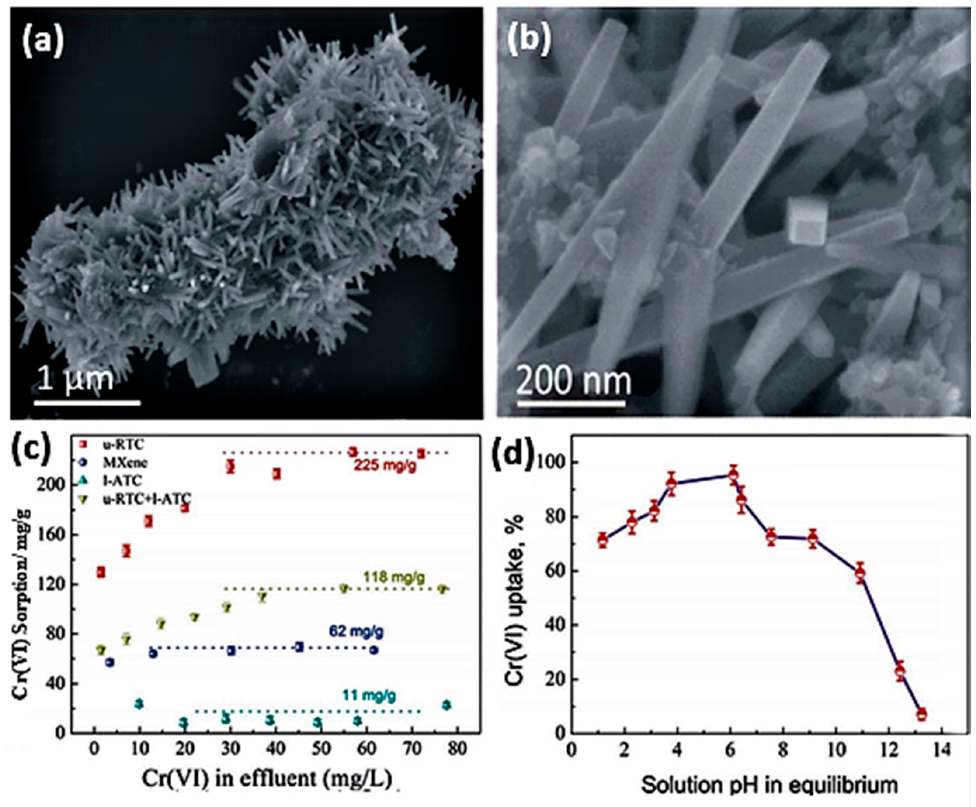
Figure 6. ( a ) SEM image of the u-RTC composite prepared in (MXene-IPA0.5 EG)-1 FeCl 3 (12 h). ( b ) Local high magnification of u-RTC. ( c ) Cr(VI) sorption performances on the prepared l-ATC in (MXene-IPA)-0.5EG; u-RTC and lATC in (MXene-IPA-0.5EG)-1 FeCl 3 ; and u-RTC in (MXene-IPA-0.5EG)-1 FeCl 3 and the primitive MXene. ( d ) Effect of pH on Cr(VI) uptake by u-RTC. Adapted and reproduced with permission from [55]. Copyright 2016 RSC.